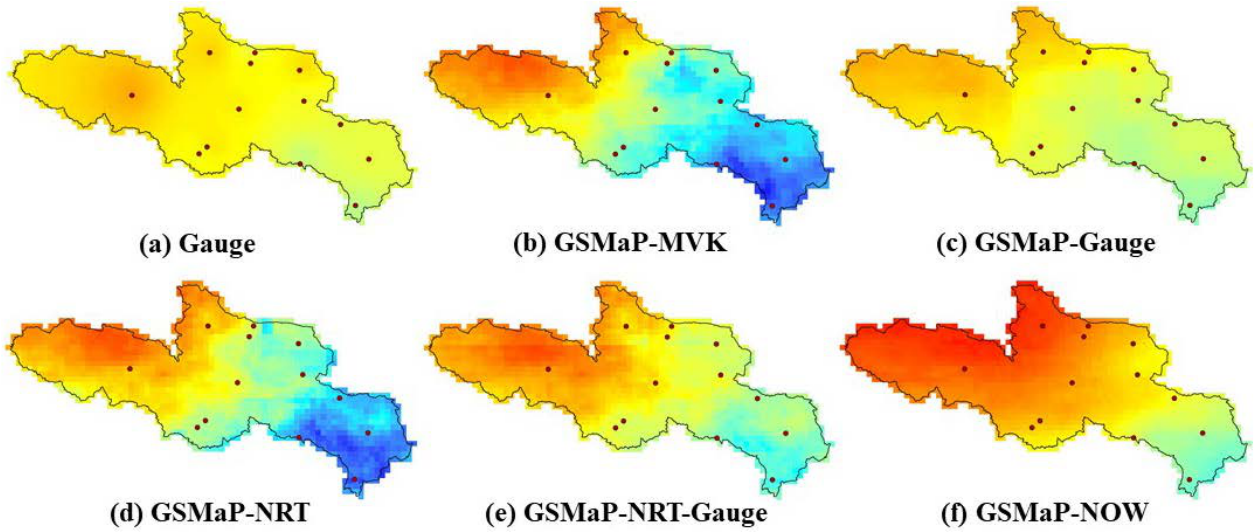
Figure 2. Spatial distribution of mean daily precipitation rates estimated from the gauge-based gridded precipitation data set and five GSMaP SPPs from 29 March 2017 to 31 December 2018.